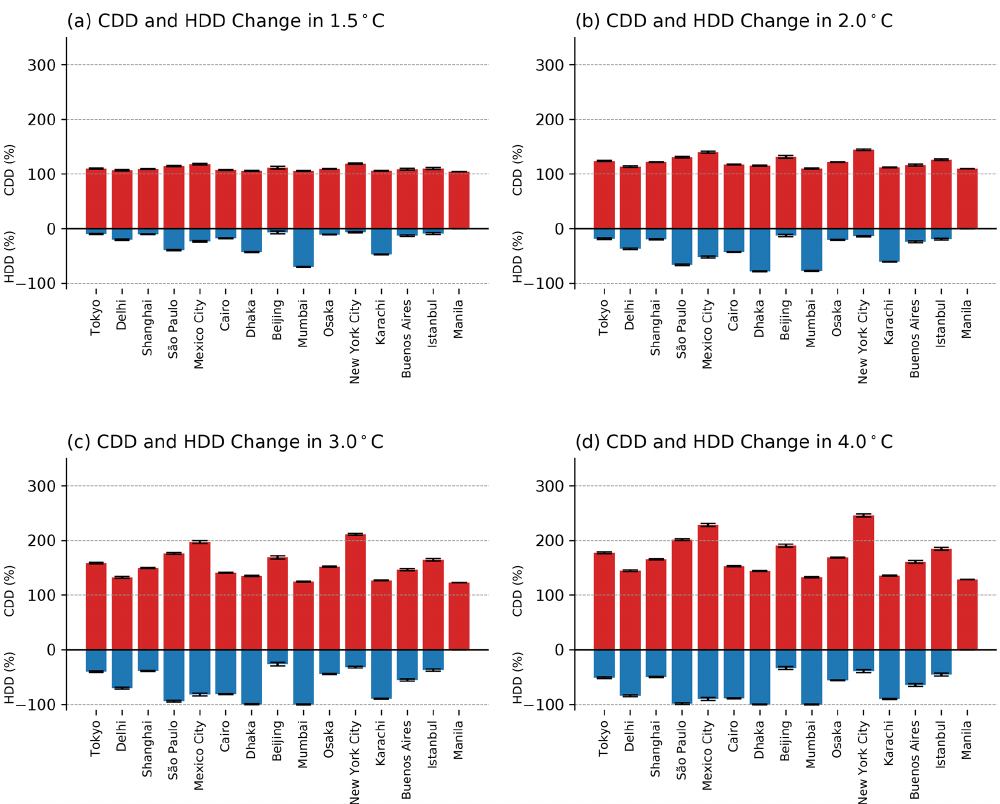
Figure 9. Change (in percentage) of ensemble-averaged cooling degree days (CDD; red) and heating degree days (HDD; blue) compared to the reference climate (0.87 ◦ C) in the 1% CO 2 experiments at the time they reach the global mean temperature thresholds of (a) 1.5 ◦ C, (b) 2.0 ◦ C, (c) 3.0 ◦ C, and (d) 4.0 ◦ C, respectively. Error bars represent the standard deviation in CDD and HDD values between the ensemble